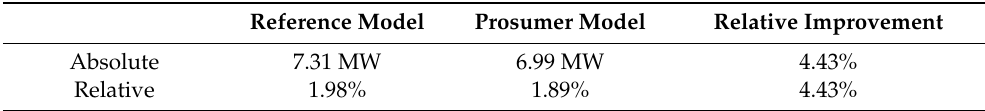
Table 5. RMSE between the aggregated modelled feed-in and the transfer time series EUZ for the reference “PV-scaled” and the simulated prosumer model (absolute and relative to the total nominal power) and relative improvement (Equation